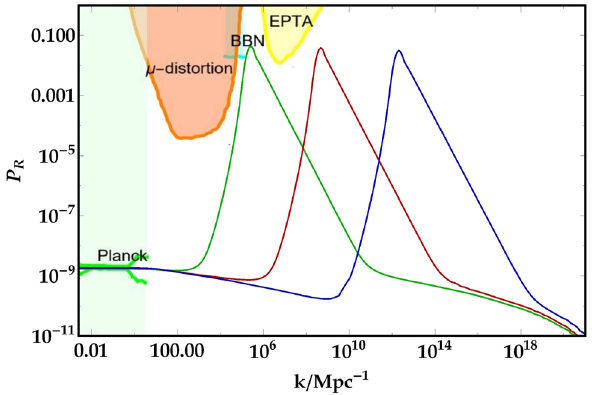
Fig. 4 Same as Fig. 2, but for the natural inflation model. The blue, red and green lines are corresponding to the cases A N , B N and C N ,